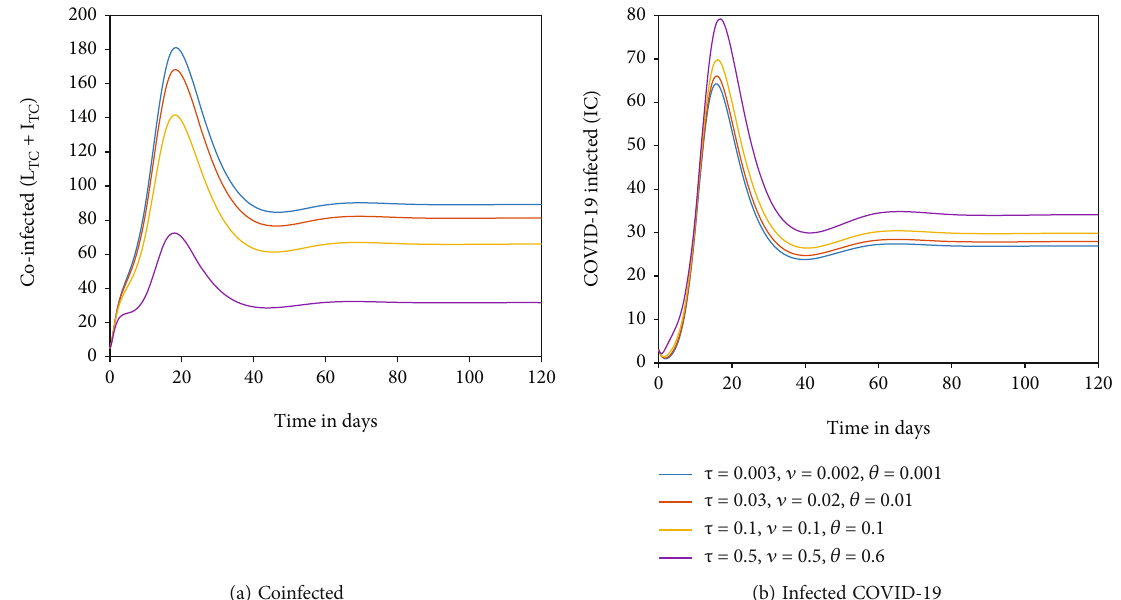
Figure 12: Impacts of τ , ν , and θ on the coinfected classes ( L